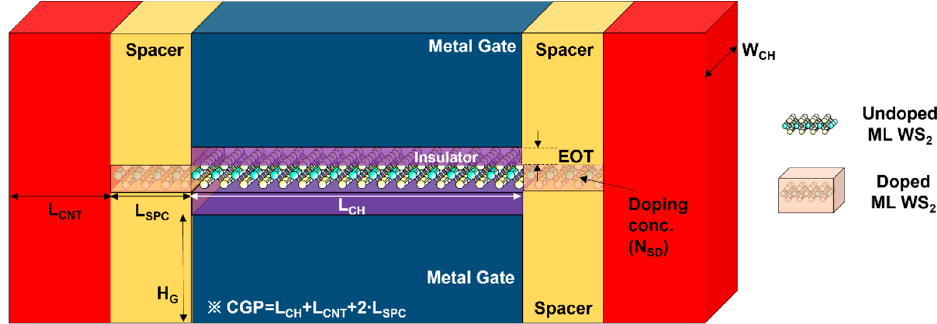
Figure 1. Structure of DG WS 2 -FET used in this work. Table 1. Key device geometric parameters of DG WS 2